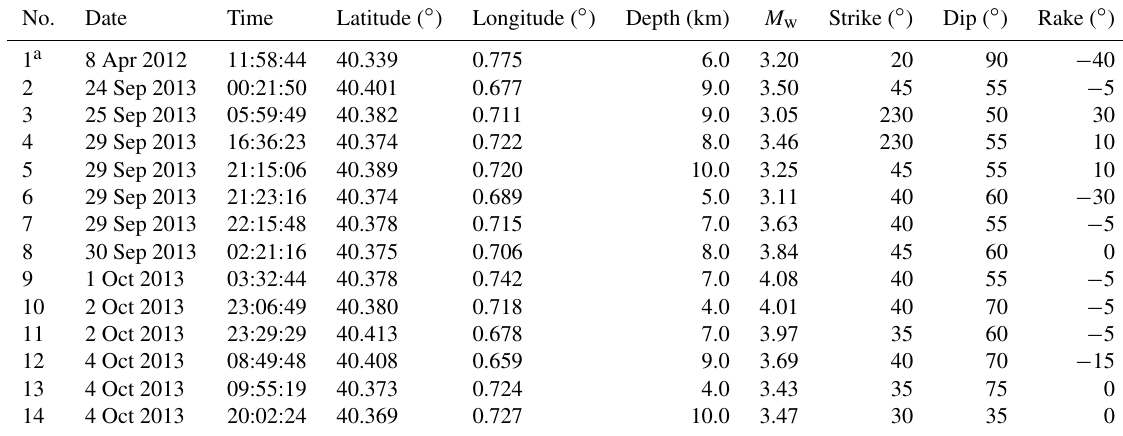
a This event occurred before the 2013 seismic sequence.